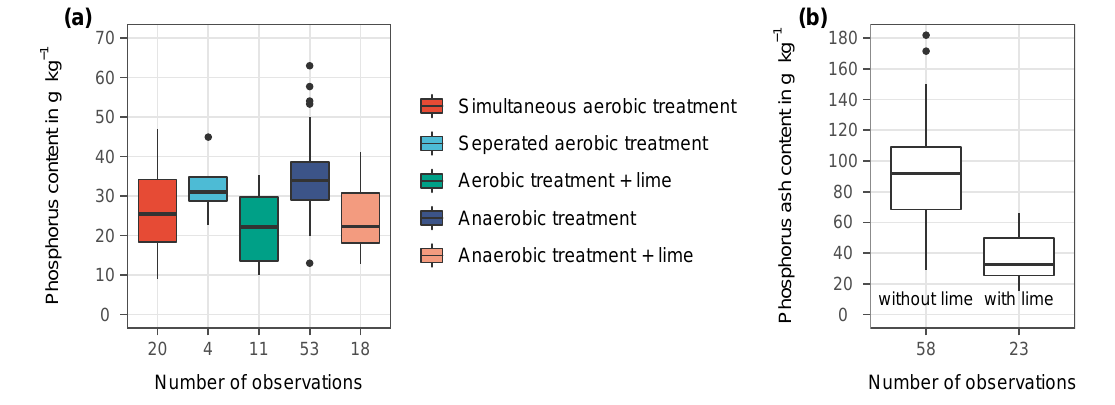
Figure 6. ( a ) P content in grams per kilogram as a function of the primary sludge stabilization method, and ( b ) derived P ash content as a function of lime addition. Statistical values are provided in Table